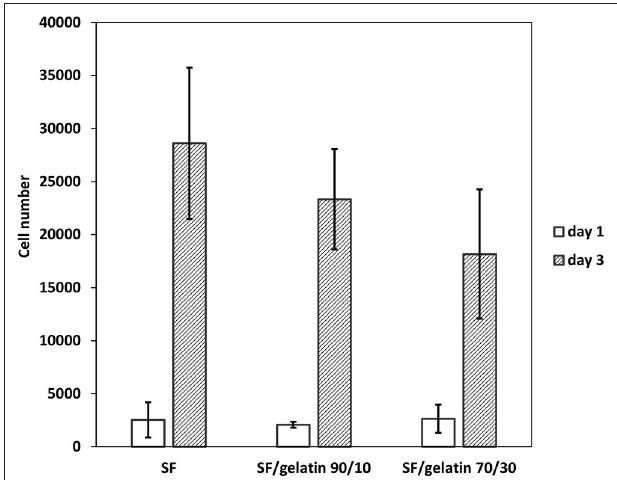
FIGURE 10 | Proliferation of 3T3 fibroblasts seeded on GTA crosslinked SF nanofiber mats and SF/gelatin nanofiber mats after the first and third days of cell